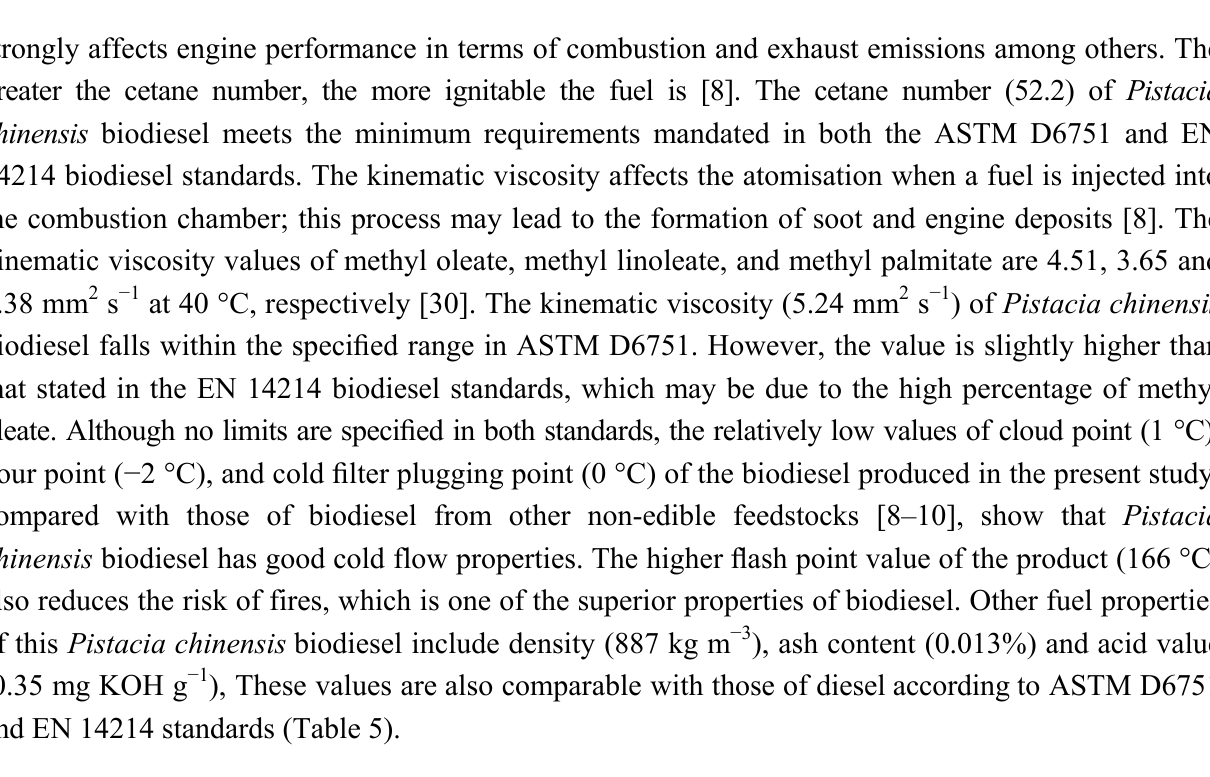
Table 5. Property comparison of Pistacia chinensis biodiesel with ASTM D6751 and EN 14214